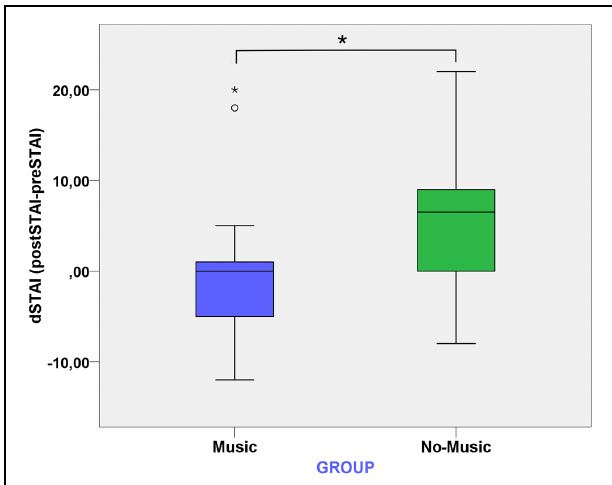
FIGURE 5 | Scatter plot of the linear correlation between Acrophobia Questionnaire (AQ) scores and percentage of change in heart rate (HR) values when subjects ascended in the